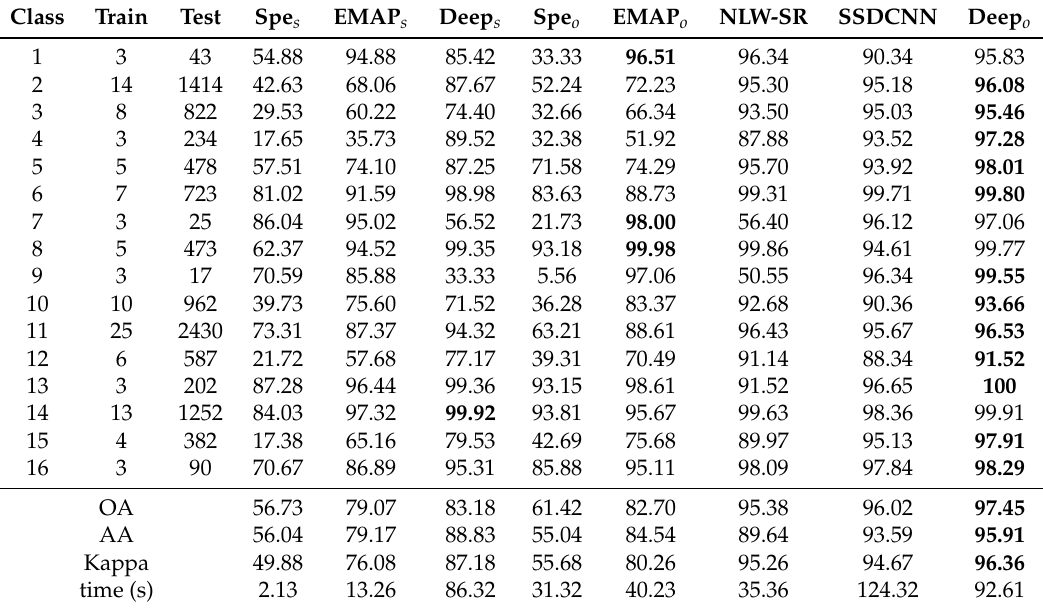
Table 1. OA, average accuracy (AA) and Kappa statistic obtained after executing 10 Monte Carlo runs for the AVIRIS Indian Pines